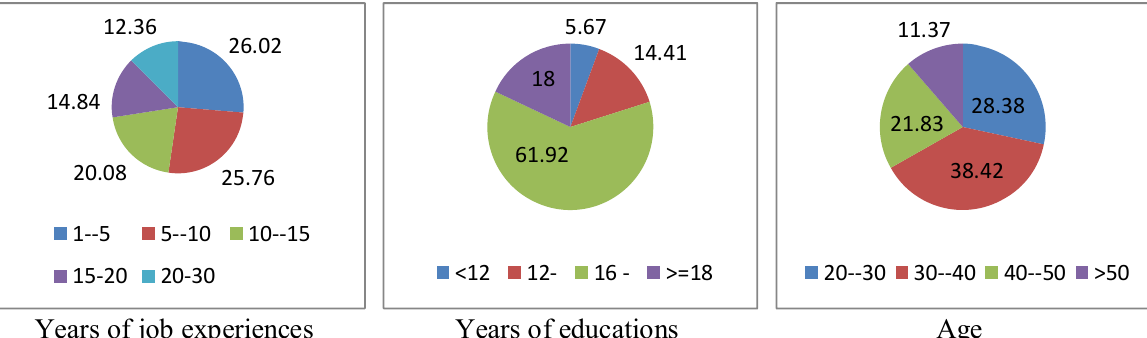
Fig. 1. Personal characteristics of the